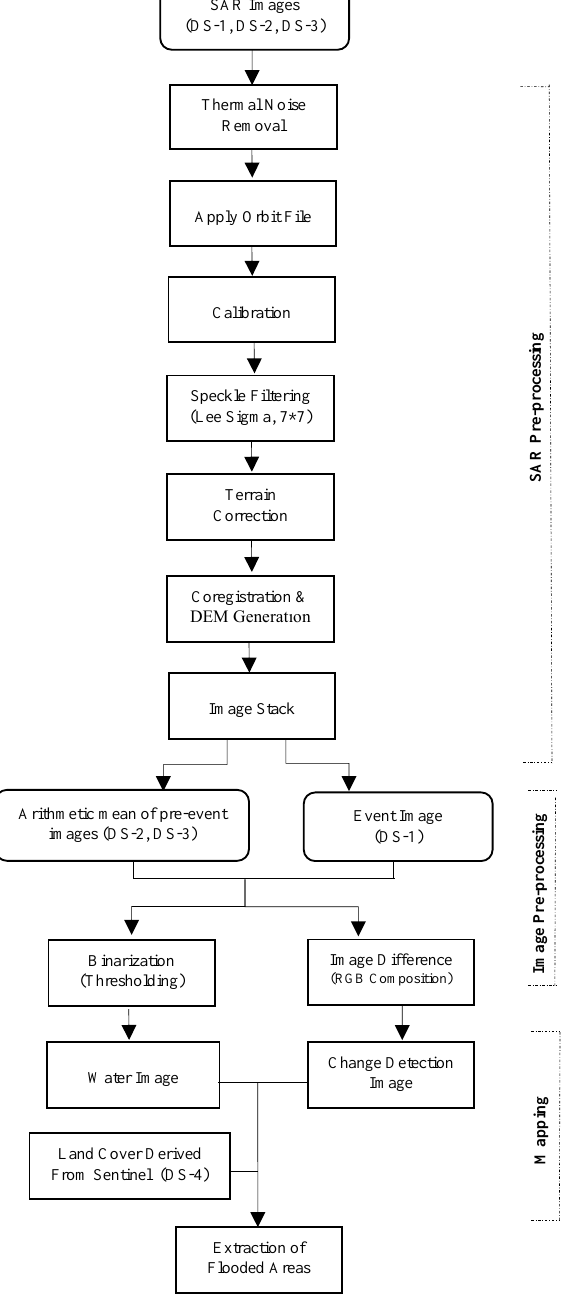
Figure 3. Flowchart of the methodology. Thermal noise affects the quality of the images, especially in low backscatter areas like calm seas and lakes. Therefore, thermal noise was removed in this step using the SNAP Toolbox. Precise orbit file was applied, because the orbit file provides accurate satellite position and velocity information. (SNAP